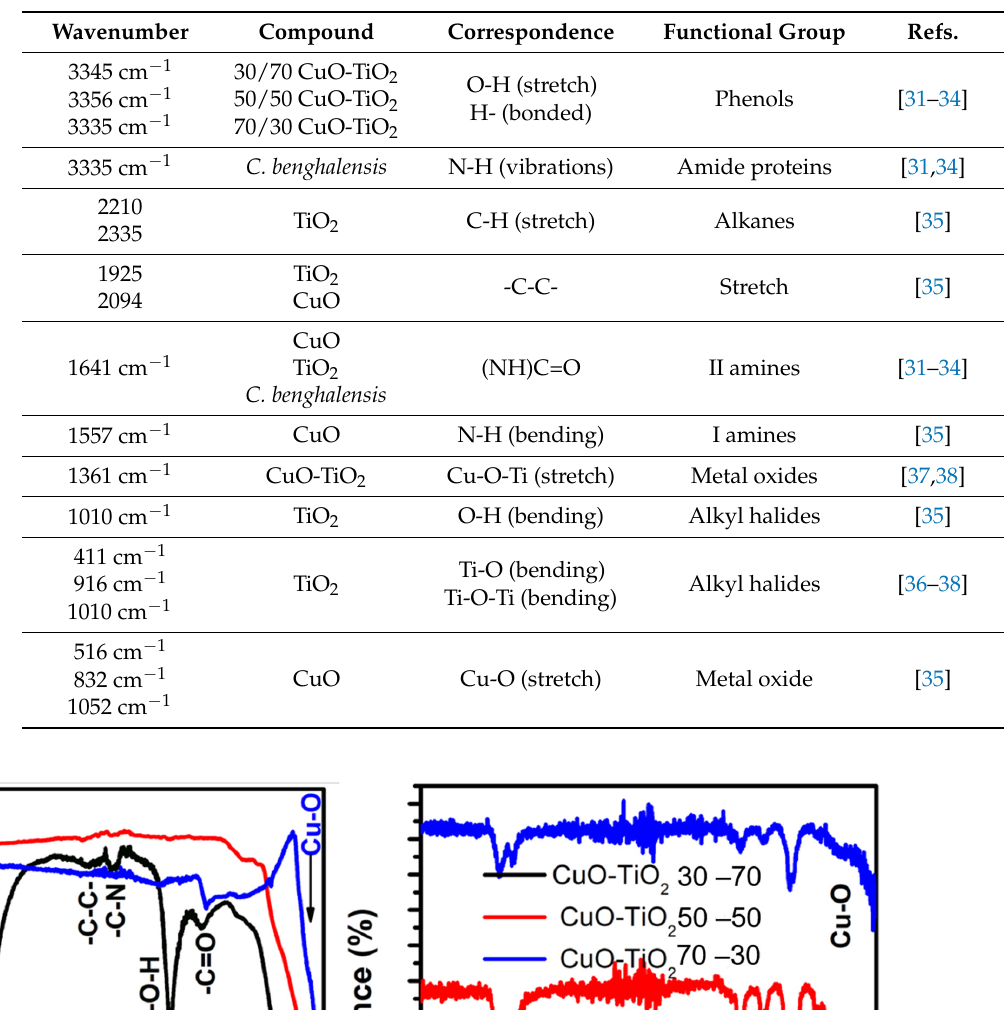
Table 1. The IR peaks depicted for C. benghalensis plant extract, C. benghalensis -mediated CuO, and TiO 2 nanoparticles.